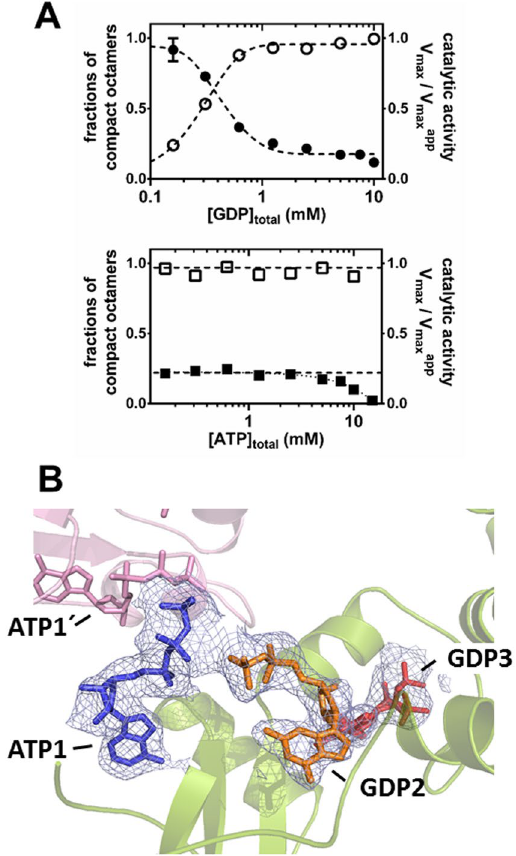
Figure 5. The conformational switch of AgIMPDH is unidirectional. ( A ) Plots representing the fraction of compact octamers (empty symbols) and the catalytic activity (filled symbols) versus nucleotide concentration. Upper panel: 3 mM ATP fixed versus increasing concentrations of GDP. Lower panel: 5 mM GDP fixed versus increasing concentrations of ATP. Data points represent the mean value and the standard errors. At the fixed concentrations of ATP (3 mM) and GDP (5 mM) used for these experiments, all AgIMPDH remained as octamers with no detectable fraction of tetramers, as determined by SAXS. ( B ) Close-up view of the nucleotides bound to the Bateman domain in the structure AgIMPDH-ATP/GDP. The protein is represented in green cartoons and the nucleotides in coloured sticks (ATP1 in blue, GDP2 in orange, and GDP3 in red). The interacting Bateman domain form the other tetramer is shown in light pink. The grey mesh around the nucleotides represents the ommit 2mF o − DF c electron density map contoured at the 1 σ